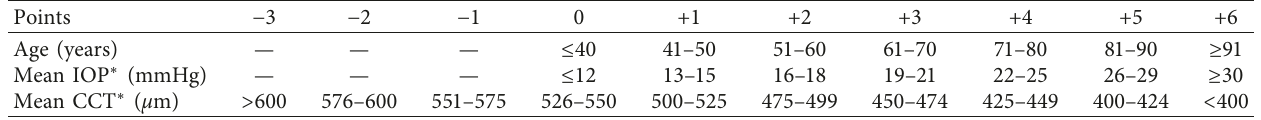
Table 1: The Laroche glaucoma calculator: risk factors with corresponding numerical variables.